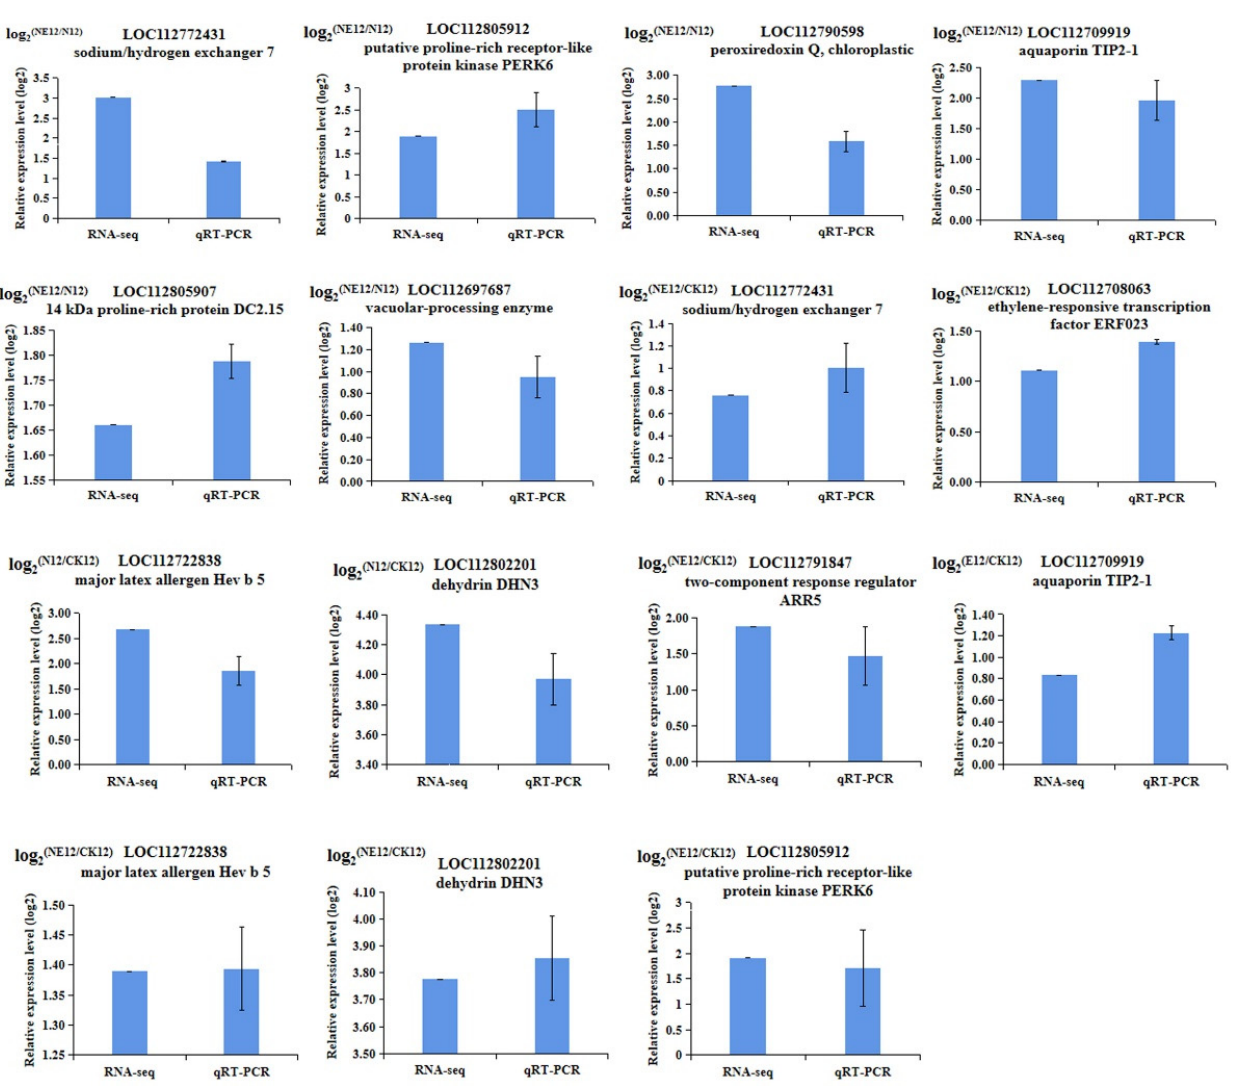
Figure 10. Verification of differentially expressed genes by qRT-PCR.